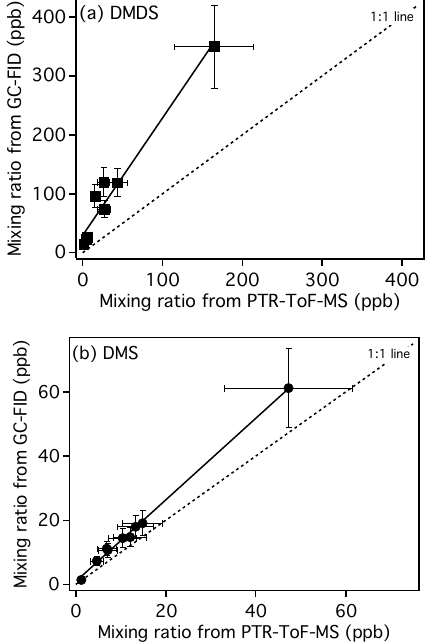
Figure 7. Intercomparison between GC-FID and PTR-ToF-MS measurements of (a) DMDS and (b) DMS from the bin source sam- ples. The dotted lines correspond to the 1 : 1 line (line of perfect agreement) and the black lines correspond to linear regression fits with y = 0.89 + 1 . 27 x for DMS ( r 2 = 0.997) and y = 29 + 2 . 00 x for DMDS ( r 2 = 0.956).